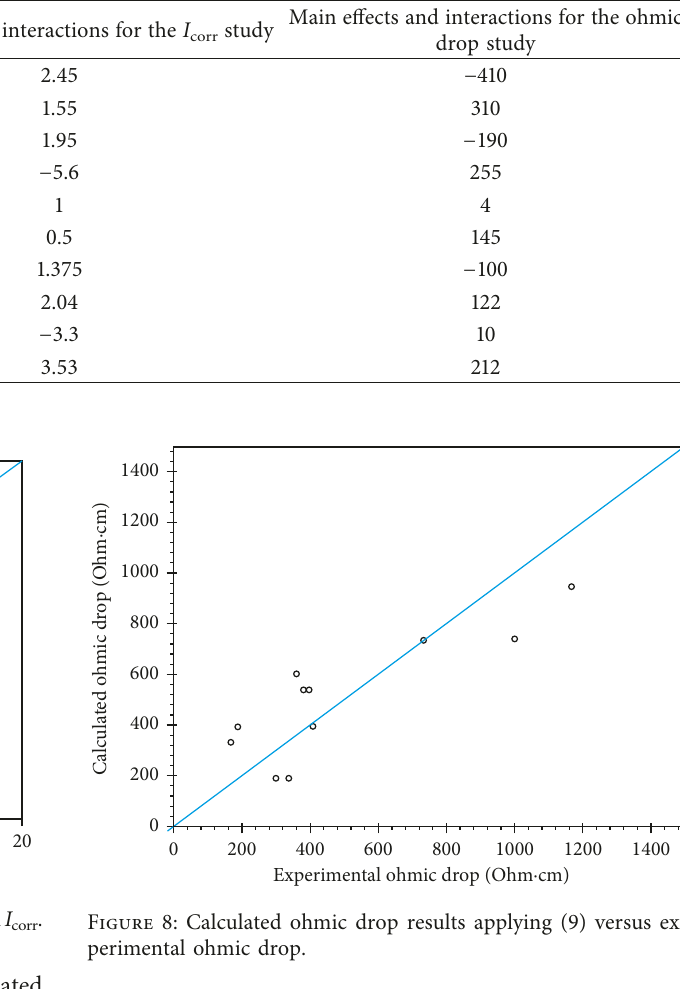
Table 2: Main effects and interactions.